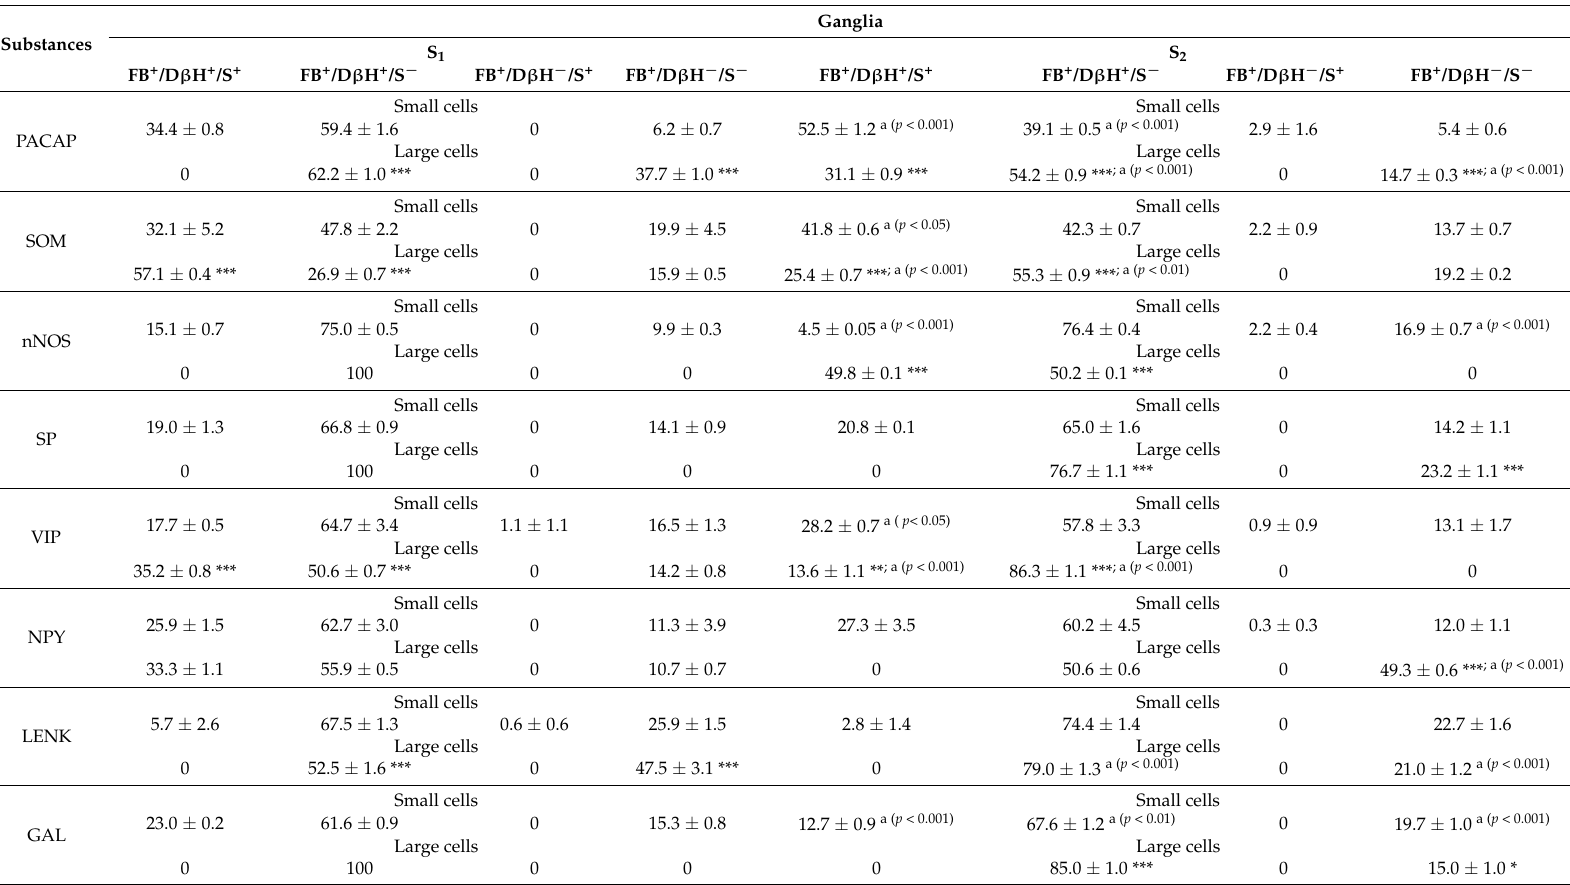
Table 2. Percentages of retrogradely labeled small and large cells in the porcine sacral (S 1 –S 2 ) sympathetic chine ganglia projecting to the skin of the